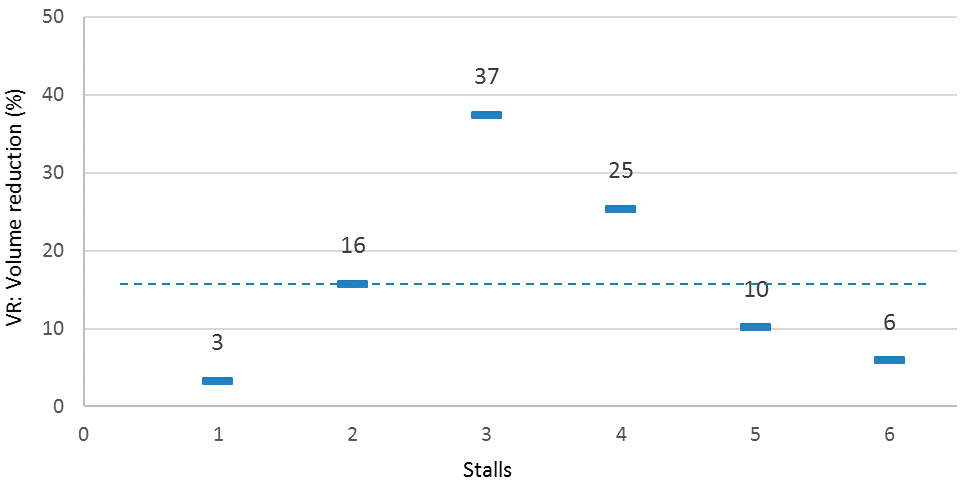
Figure 4. Total volume reduction ( VR total ) for each of six stalls over a period of 12 months. Mean volume reduction across all stalls shown as dashed line.